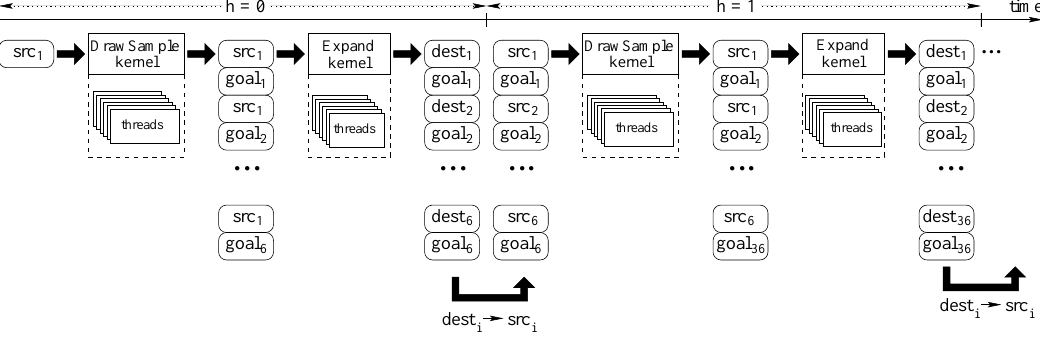
Figure 5. Memory organization for thread communication concentrates on a tree of degree ( D ) equal to 2. For h = 0, the DRAW S AMPLE K ERNEL kernel generates D = 6 goal destinations goal i . The EXPAND K ERNEL kernel tries to reach these goals, and it generates 6 destinations dest i , as close as possible to the corresponding goal. For h = 1 all operations are repeated starting from 6 source positions (the 6 destinations reached at the previous iteration).